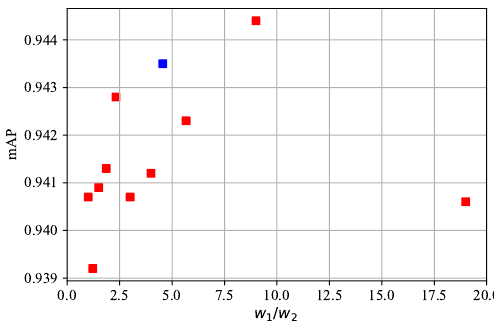
Figure 5. Analysis of mean Average Precision for different weights relations used in the WDMC loss function . Blue marker indicates the weights relation calculated based on the proportion of changed and unchanged